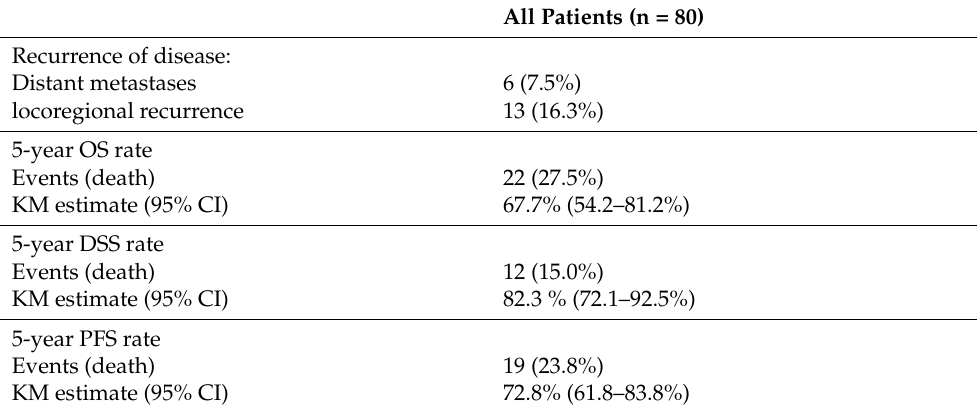
Table 3. Oncological